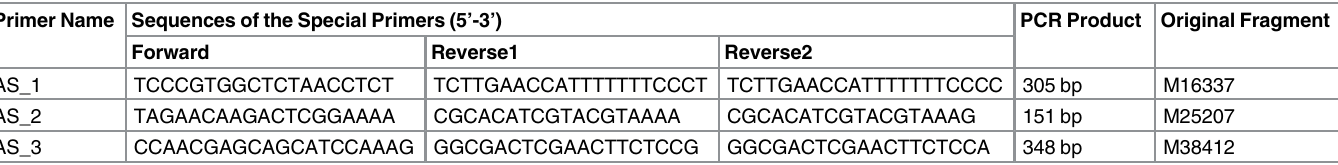
Table 6. Primer sequences of the AS-PCR and the SNP